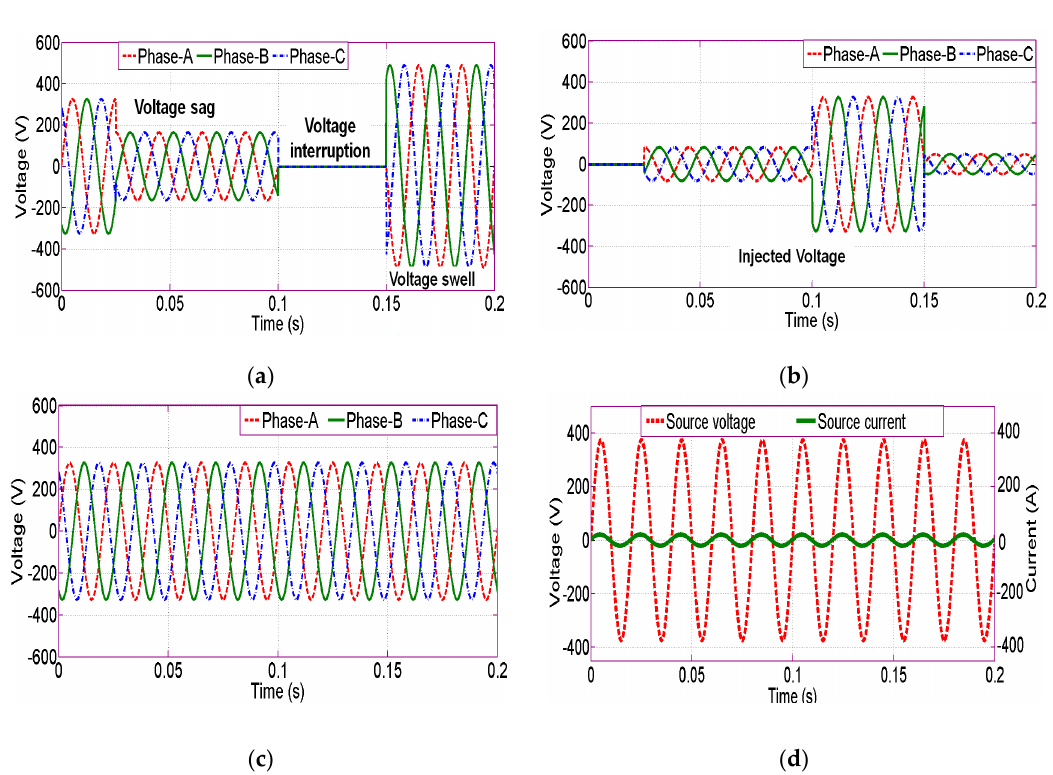
Figure 7. Simulation results under steady state voltage and current: (a) supply voltage; (b) injected compensation voltage; (c) load voltage; and (d) source voltage and source current.